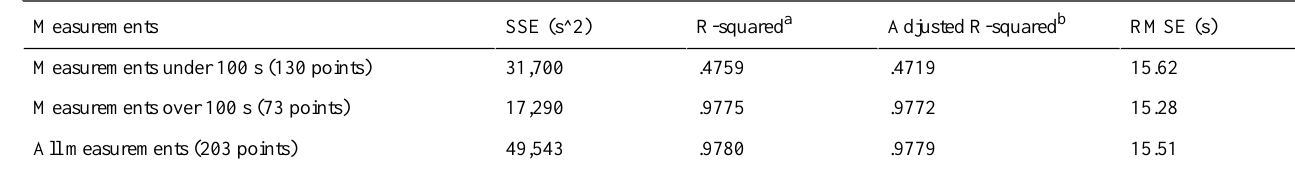
Table 2. The goodness of fit between the measured and the expected values of model 3 ( w =1.0). SSE: sum of squares due to error, which is a measure of the discrepancy between the data and the model estimated; RMSE: root mean square error that is the standard error of a measurement, the standard error of the